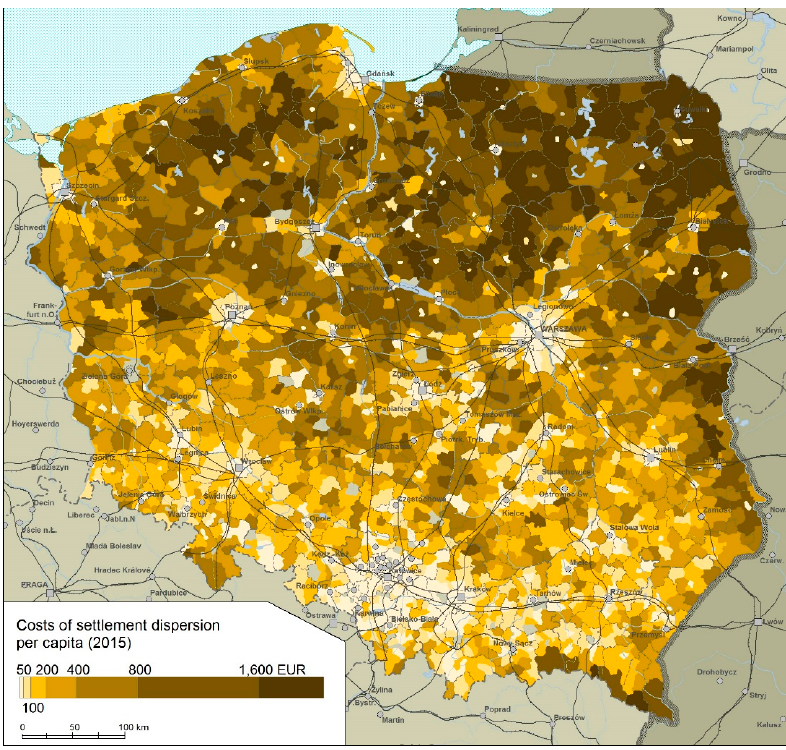
Figure 2. Costs of excessive dispersion of buildings per capita in Poland in 2015 by communes. Source: [45].